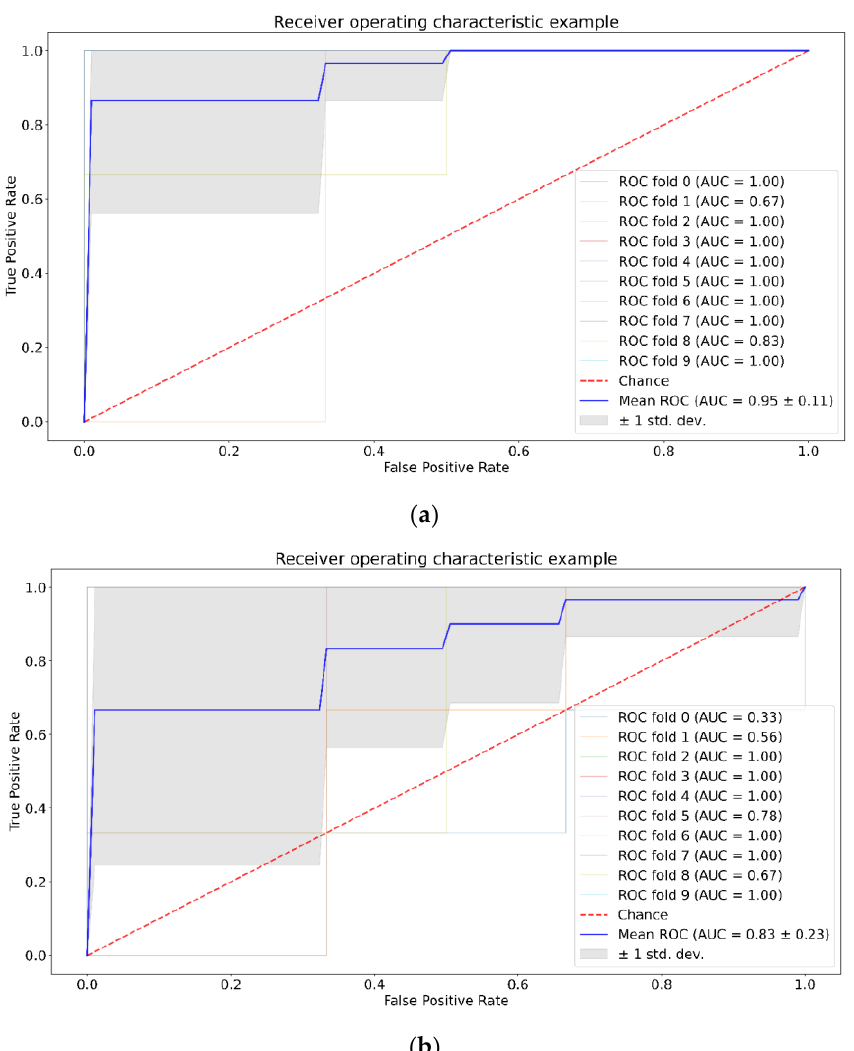
Figure 7. ROC AUC analysis for XGBoost, third week, no PCA ( a ) and with PCA ( b ). Table 2. Mean and standard deviation of AUC for SVM, RF, XGBoost.